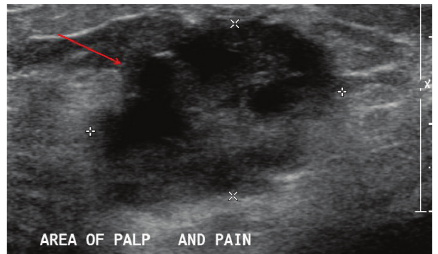
Figure 1: A three-centimeter partially solid mass in the left breast.